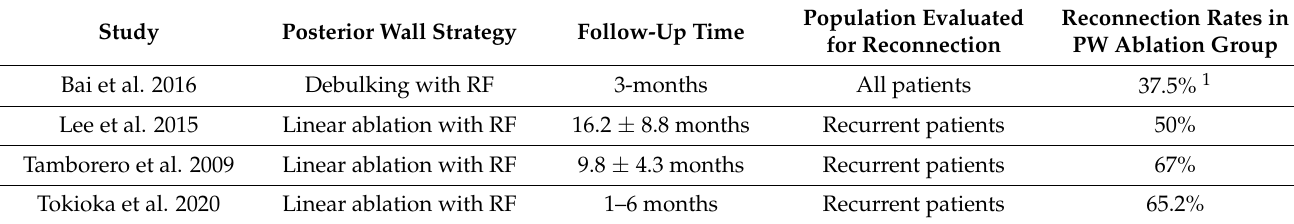
Table 2. Posterior wall (PW) connection rates in studies comparing pulmonary vein isolation (PVI) to PVI + PW isolation.